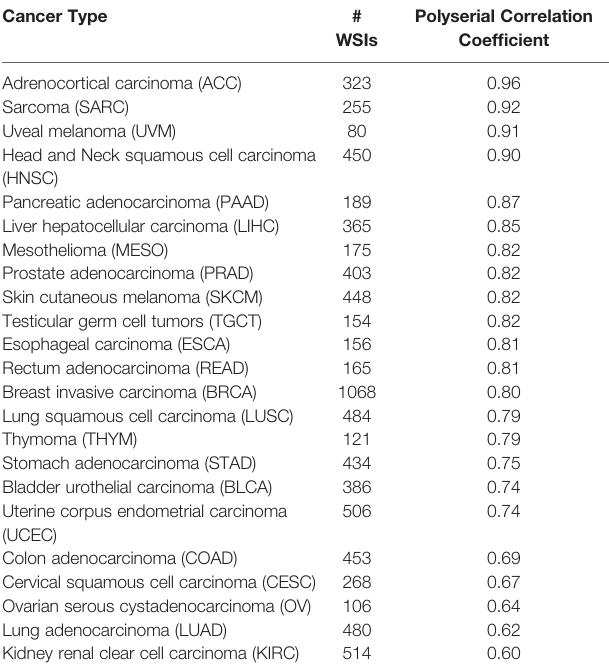
TABLE 5 | The list of cancer types in TIL-Maps-23, the number of WSIs for each cancer type, and the polyserial correlation coef fi cients for the Inception-V4 model, sorted in descending